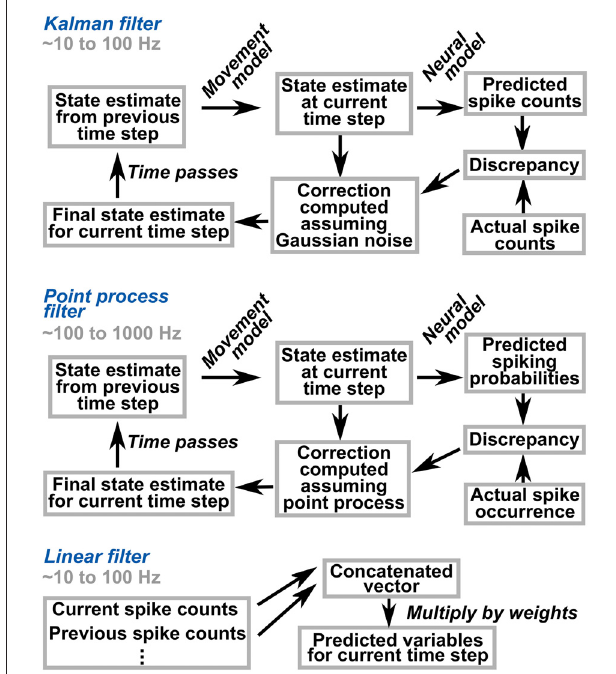
FIGURE 1 | Schematic illustration of popular decoding algorithms. The Kalman and point process filters are based on the notion of a state, which holds the current estimates of the variables of interest. The state is related to neural activity through a neural model. Bayesian computations on the neural model, assuming a distribution for noise, permit probabilistic tracking of the state based on neural activity. In contrast, the linear filter is state-less; it linearly maps the recent history of neural activity to estimates of the variables of